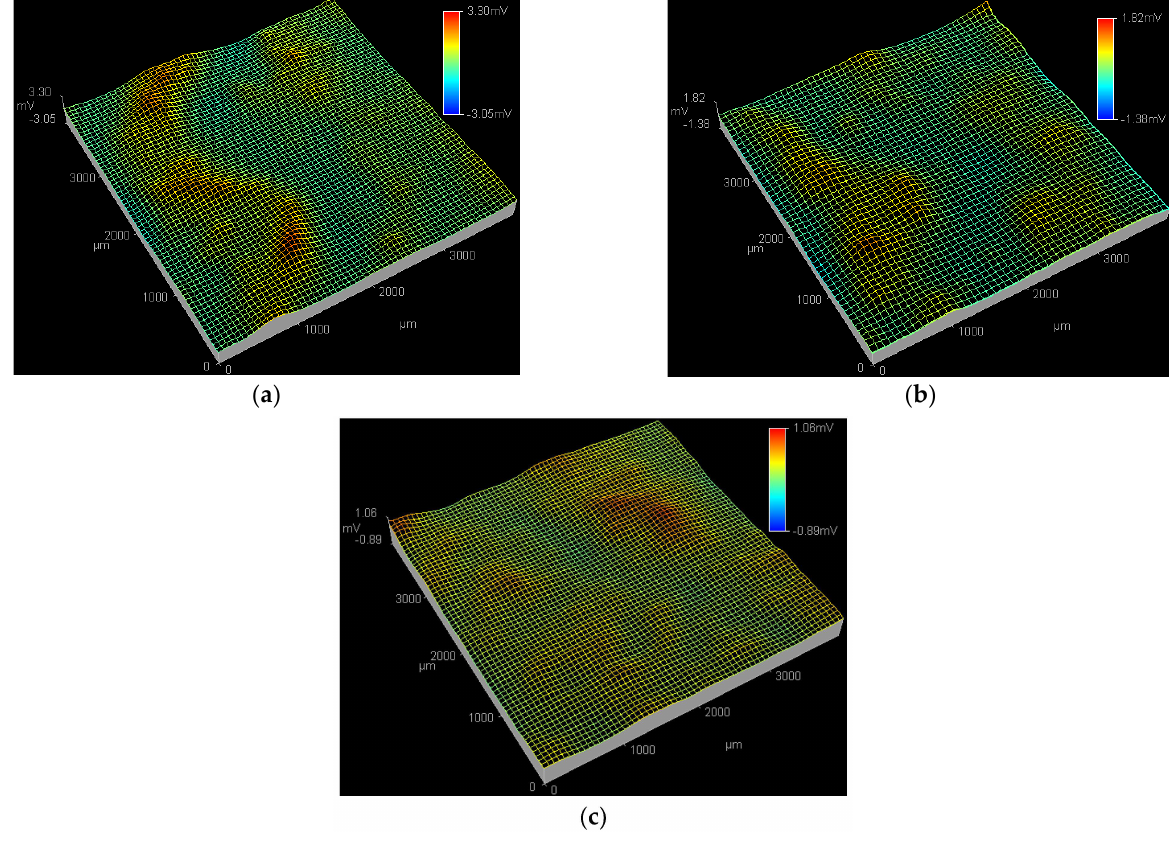
Figure 5. SPD images of the Q235 samples in WO 42 − + Cl − , MoO 42 − + Cl − and WO 42 − + MoO 42 − + Cl − solutions at applied potential of 0.17 V SCE : ( a ) WO 42 − + Cl − solution, ( b ) MoO 42 − + Cl − solution and ( c ) WO 42 − + MoO 42 − + Cl −